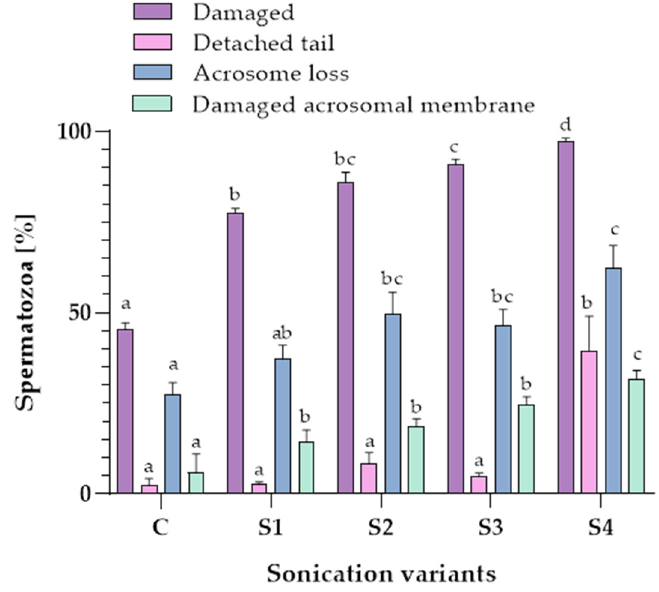
Figure 2. The evaluation of the morphological changes in dog ( Canis lupus familiaris ) cauda epididymal spermatozoa (n = 15) after the treatment with different sonication variants. C—the control sample (without sonication), S1—5 min, 50 W; S2—10 min, 50 W; S3—30 min, 50 W; S4—10 min, 150 W. Values are presented as the mean ± SE. Different sonication variants were compared with their respective control each by each. Different letters indicate significant difference ( p ≤ 0.05).